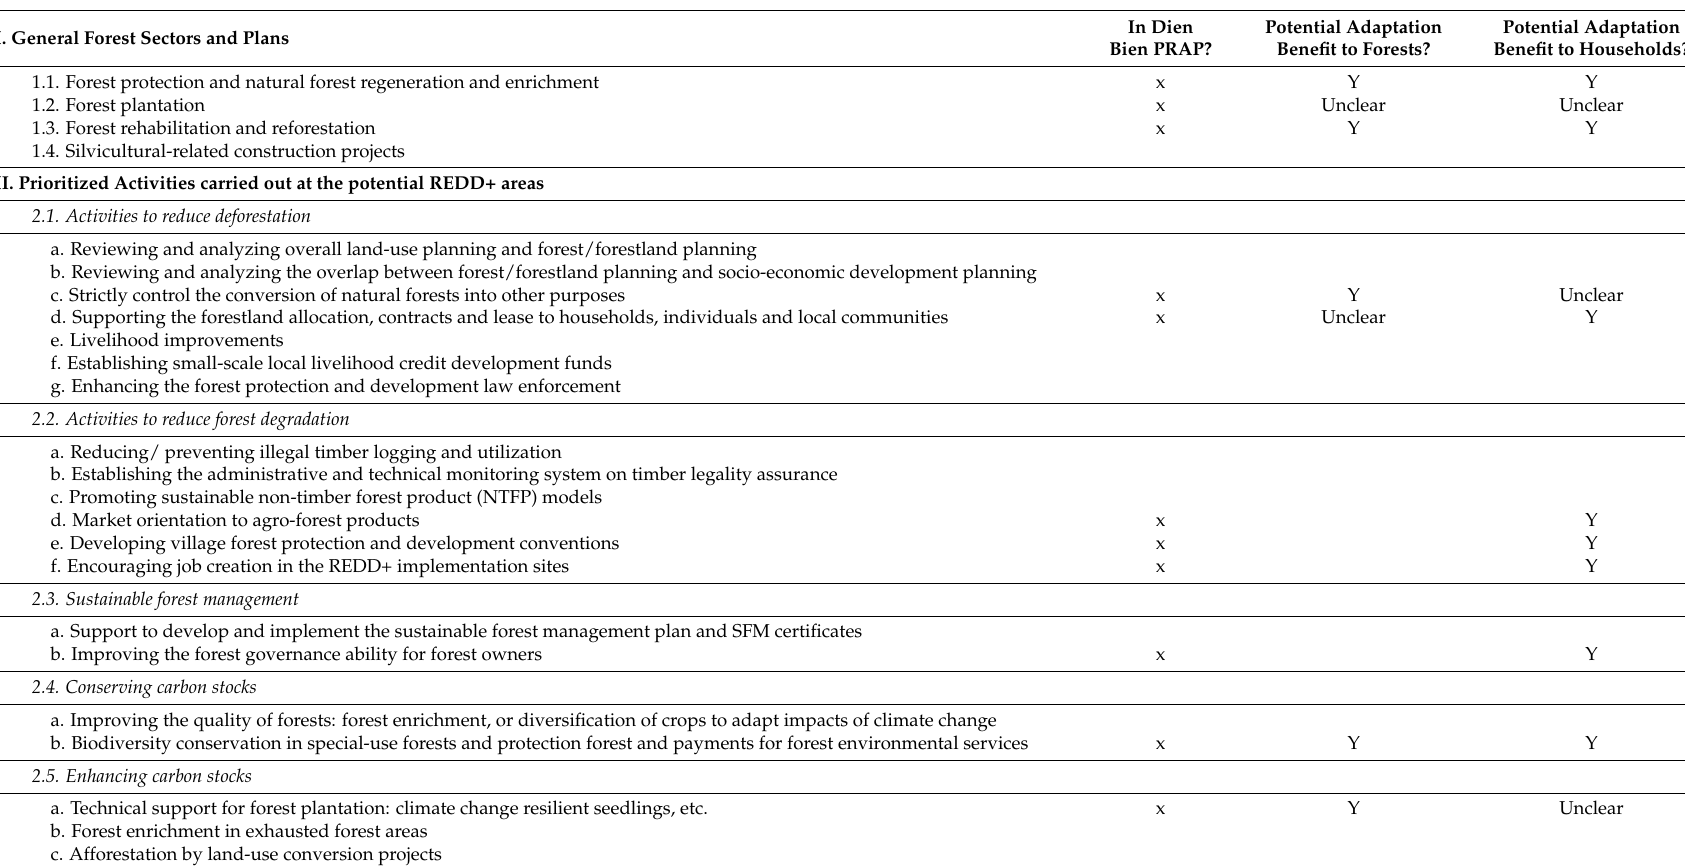
Table 1. Key sectors and activities in subnational Provincial REDD Action Plan (PRAP) in Dien Bien